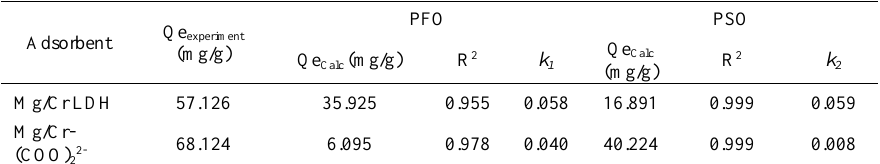
Table 2. Kinetic study malachite green